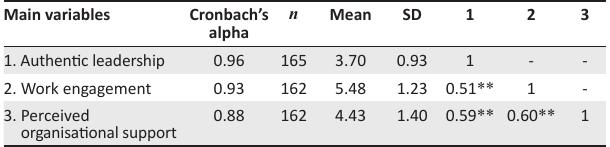
TABLE 2: Descriptive statistics, correlation and scale reliabilities for main